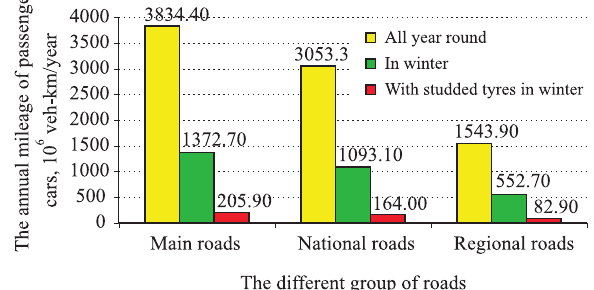
Fig. 5. Th e calculated annual mileage in the diff erent group of roads depending on the season of the year It was determined that when using passenger cars with studded tyres their fuel costs are increased by 4%, the road users (owners or managers of vehicles), solely on the roads of national signifi cance, incur the additional fuel costs of 1.68 mln